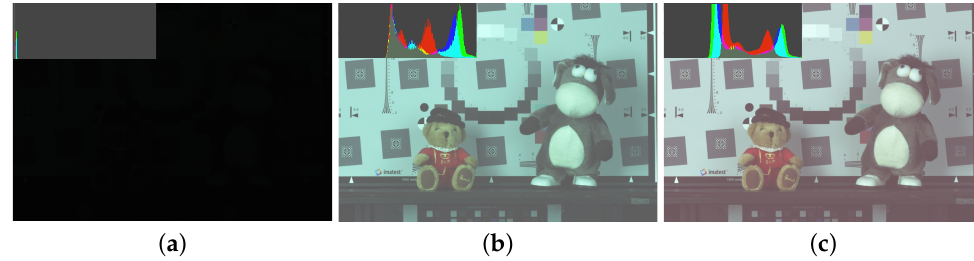
Figure 7. Images and its histograms: ( a ) The acquired image without post processing, ( b ) Linear stretching of ( a ), ( c ) The result with linear stretching and white